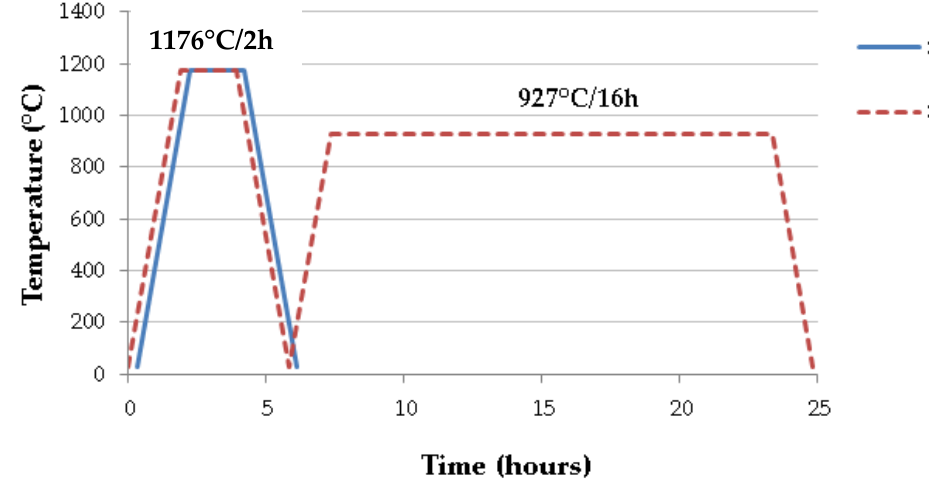
Figure 1. Heat treatments curve realized in the Inconel 713C samples.